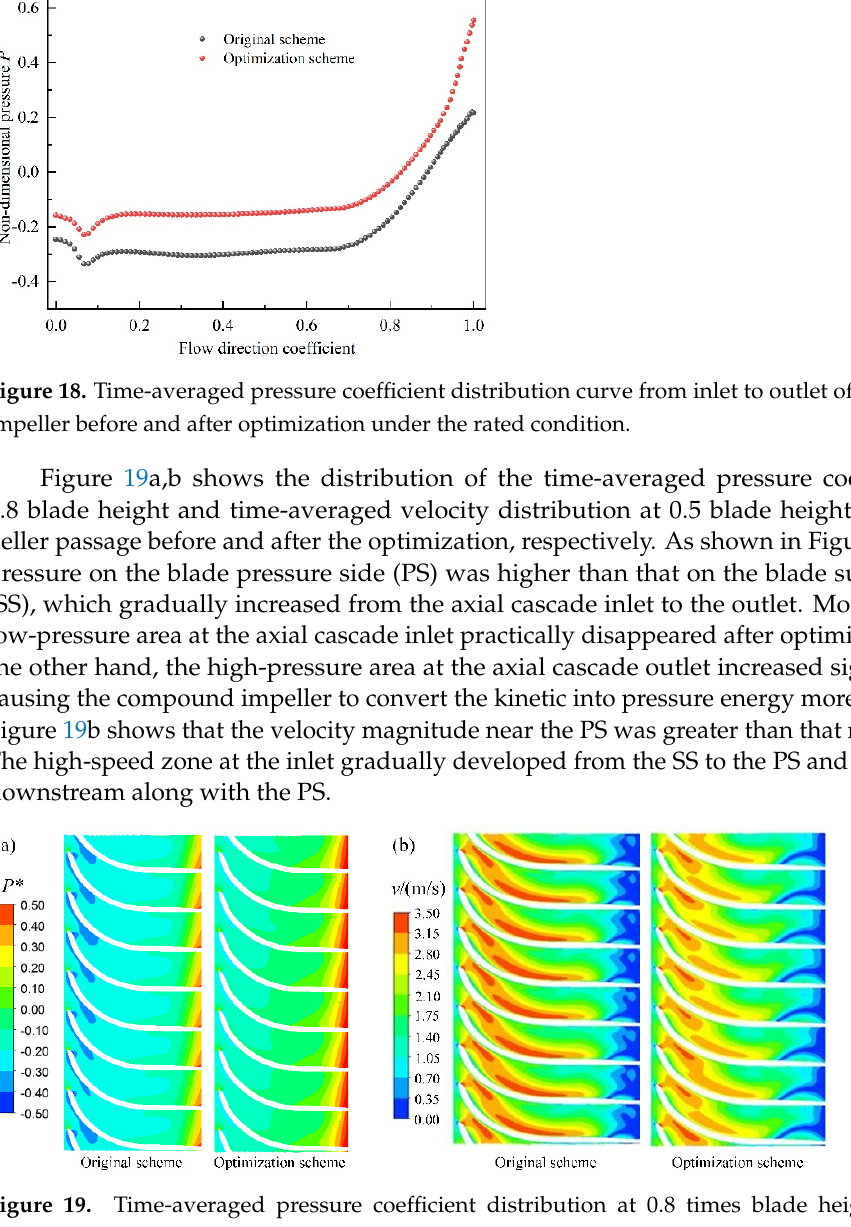
Figure 19. Time-averaged pressure coefficient distribution at 0.8 times blade height ( a ) and time-averaged velocity distribution at 0.5 times blade height ( b ) in impeller passage before and after optimization.